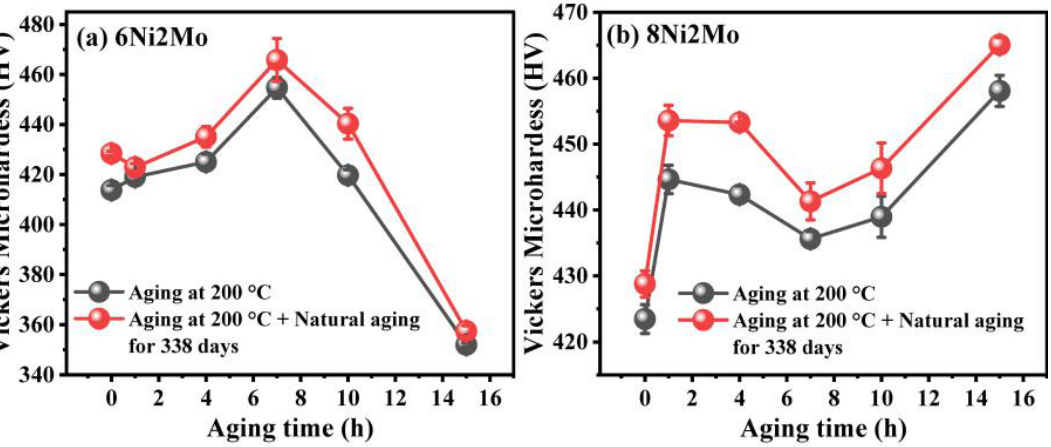
Figure 7. Vickers hardness of the 15 °C water-quenched 6Ni2Mo ( a ) and 8Ni2Mo ( b ) alloys subjected